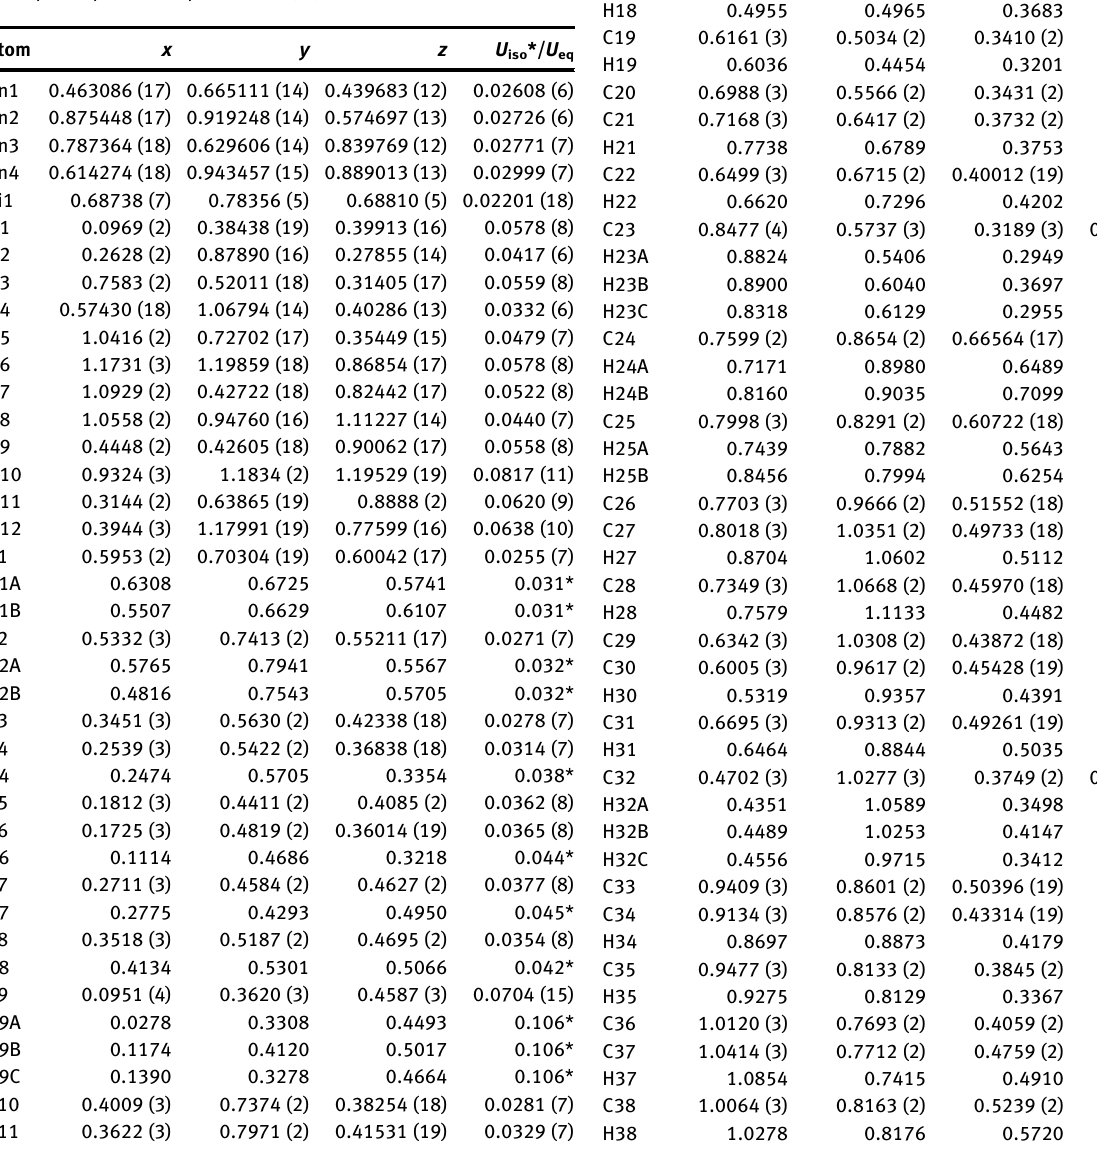
Table  : Fractional atomic coordinates and isotropic or equivalent isotropic displacement parameters (Å 